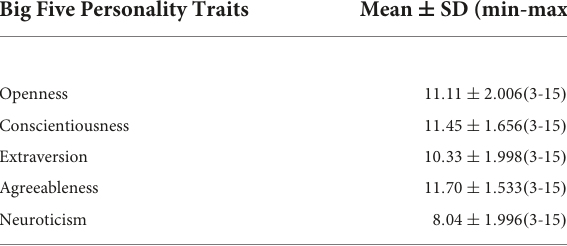
TABLE 2 Characteristic of study participants based on Big Five Personality Traits. Big Five Personality